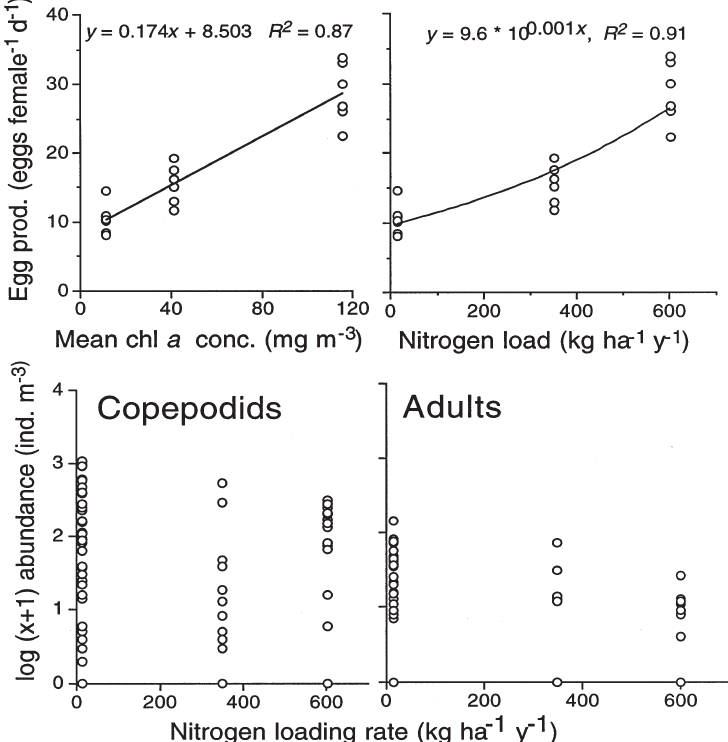
Fig. 11. – Top: Egg production by Acartia tonsa in Waquoit Bay estuaries relative to mean chlorophyll concentrations (left), and land-derived nitrogen load (right)(Cubbage et al., 1999). Bottom: Abundance of copepodids (left) and adults (right) of Acartia tonsa relative to land-derived nitrogen load to Waquoit Bay estuaries (Lawrence,